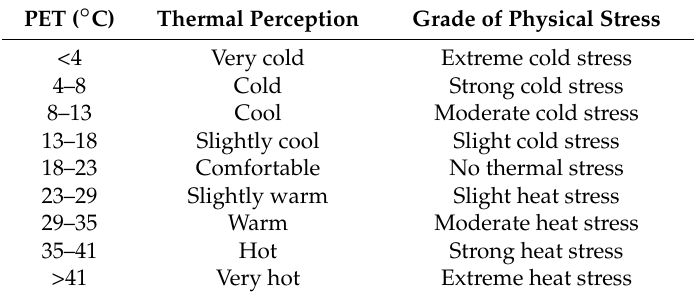
Table 2. Thermal stress classification for Central European human beings (with an internal heat production of 80 W and a heat transfer resistance of the clothing of 0.9 clo (clothing index)), modified after